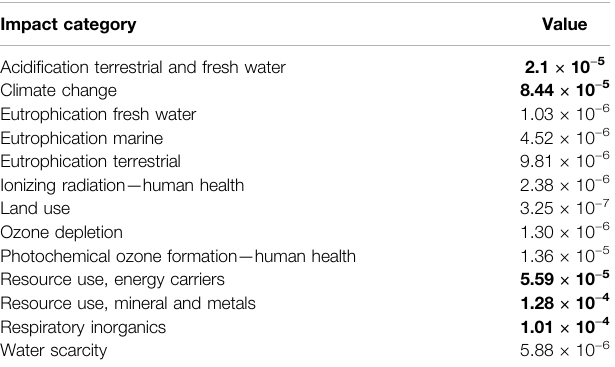
TABLE 3 | Normalized and weighted impact assessment per function kWh, with highest impact results in bold. The bold values are the highest impact